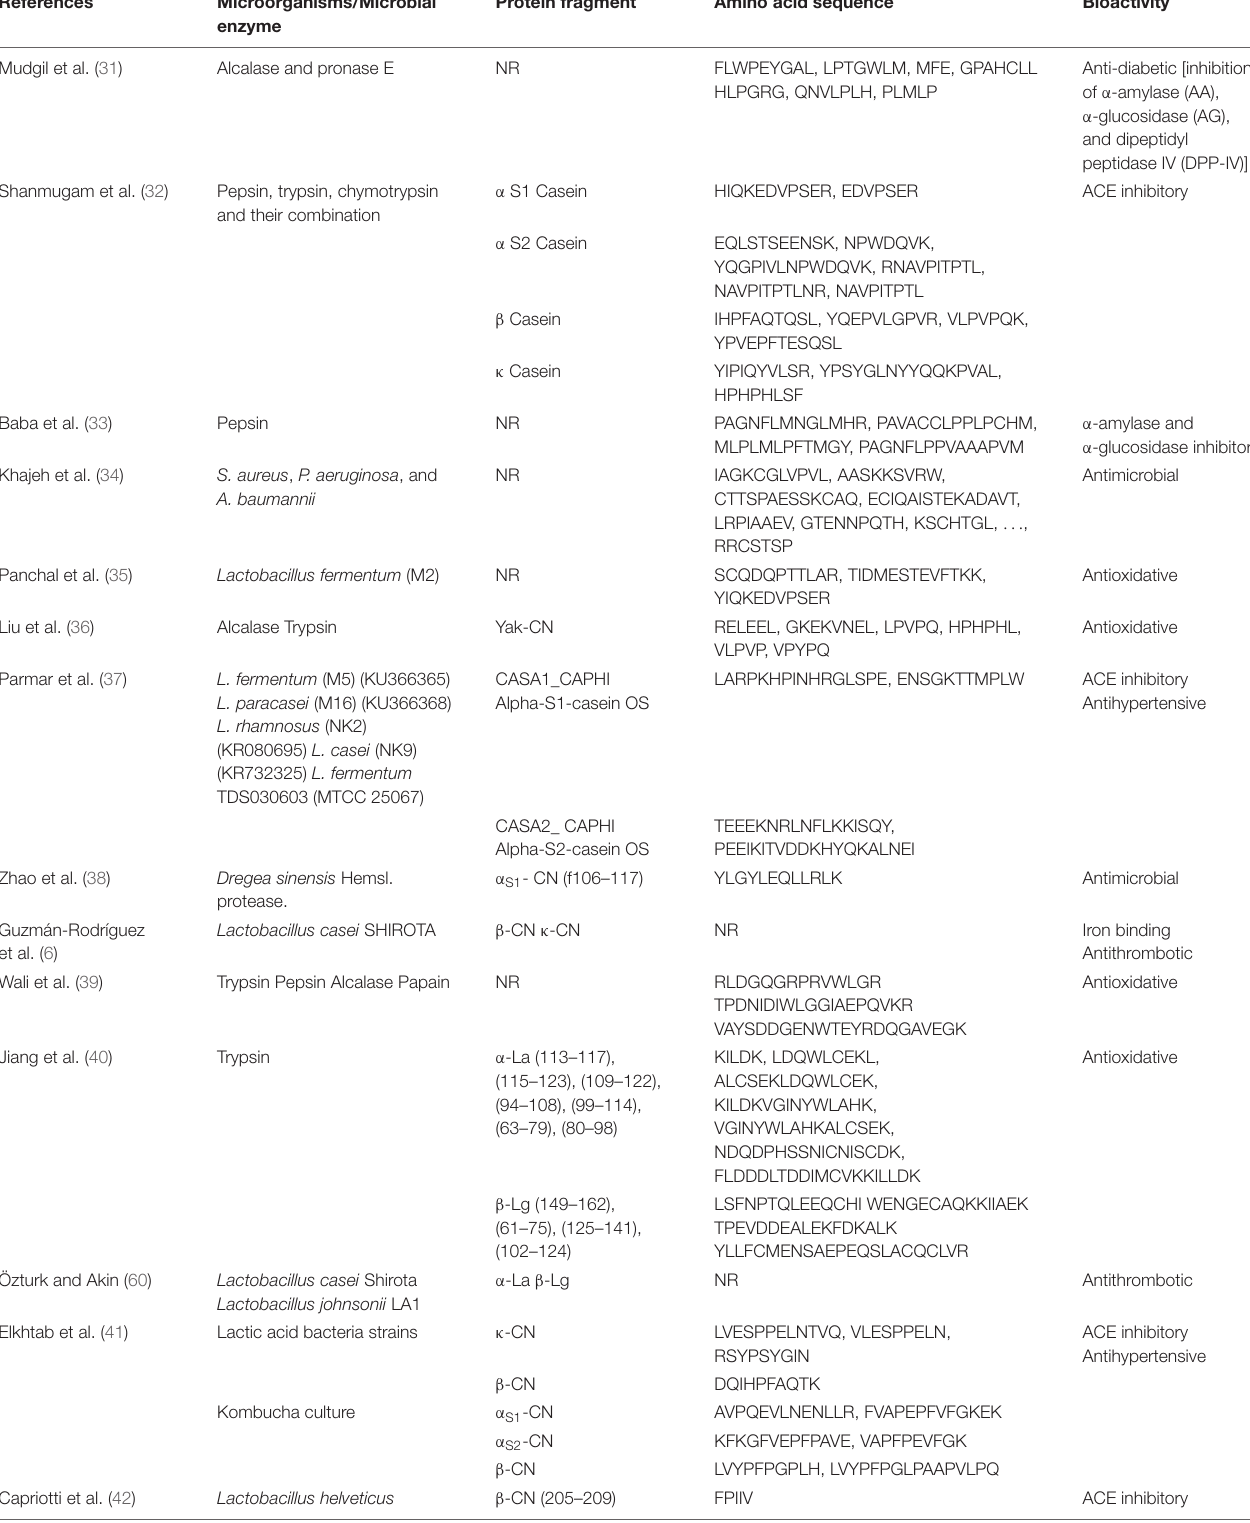
TABLE 1 | Bioactive peptides released from milk proteins by various microorganisms and microbial